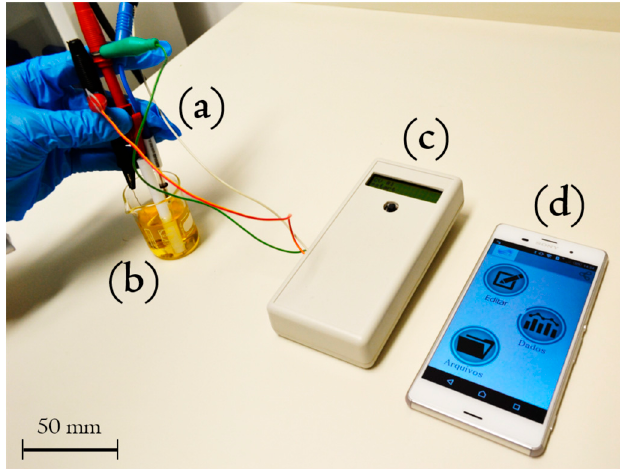
Figure 7. Portable platform deployed for point-of-use analyses. Electrochemical system. ( a ) Sample; ( b ) hand-held potentiostat; ( c ) and smartphone; ( d ) Reprinted from [29] with permission from Elsevier. http://www.sciencedirect.com/science/article/pii/S0013468616320400.